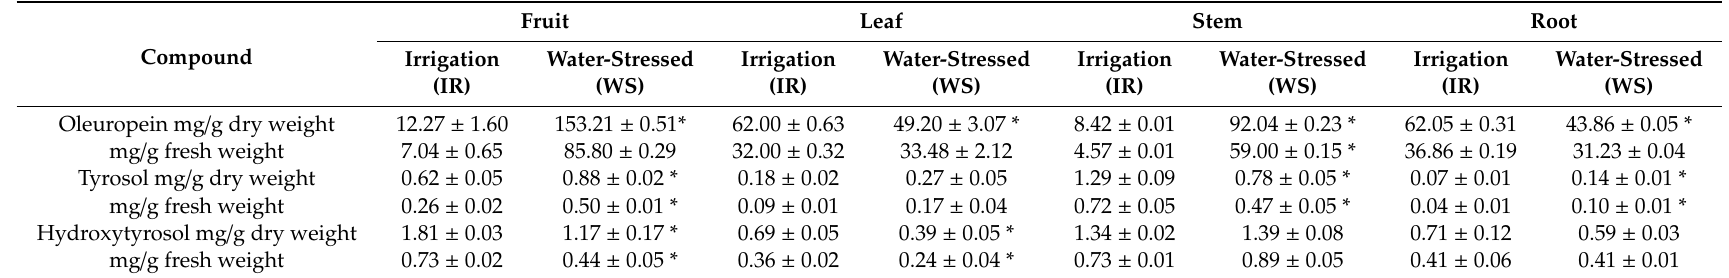
Table 3. E ff ects of irrigation on the concentration of phenolics in the fruits, leaves, stems and roots of cv. Picual olive trees. Fruit Leaf Stem Compound